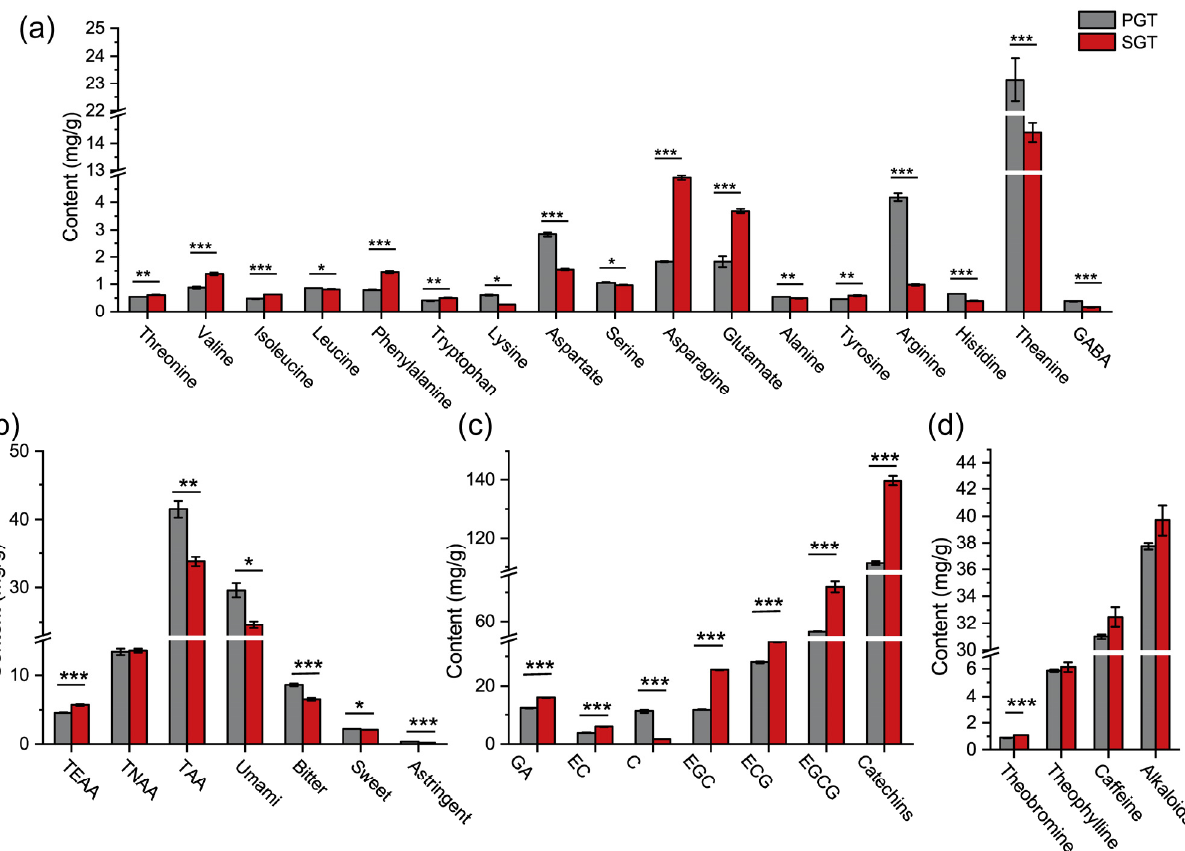
Figure 4. Effect of fixation methods on characteristic chemicals of green tea. ( a , b ) Contents of amino acids; ( c ) Contents of catechins; ( d ) Contents of alkaloids. PGT, pan-fired green tea; SGT, steamed green tea; TAA, total amino acids; TEAA, total essential amino acids; TNEAA, total non-essential amino acids; Thea, theanine; GABA, γ -aminobutyric acid; GA, gallic acid, EC, epicatechin; C, catechin; EGC, epigallocatechin; ECG, epicatechin gallate; EGCG, epigallocatechin gallate. * p < 0.05; ** p < 0.01; *** p < 0.001.